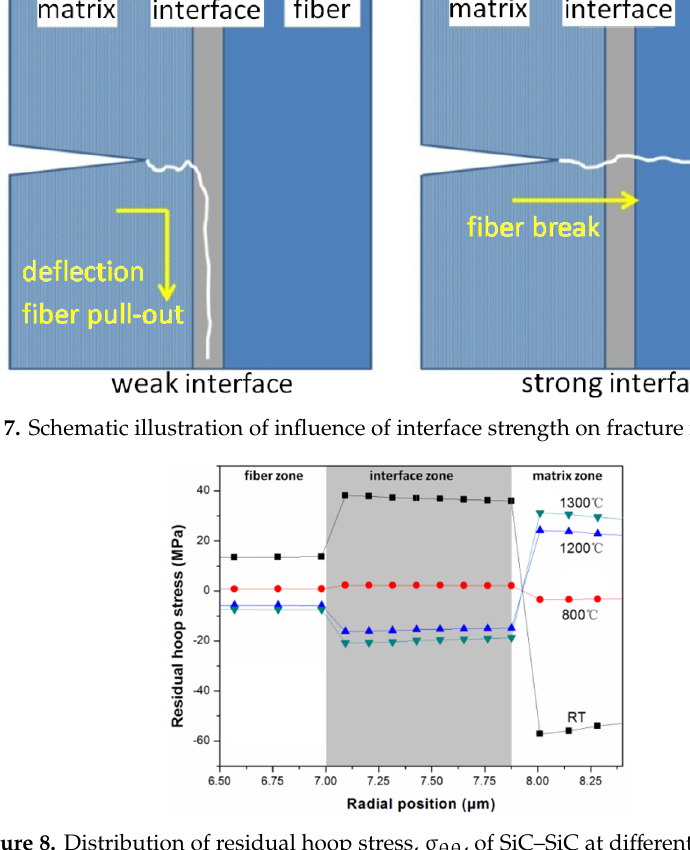
Figure 8. Distribution of residual hoop stress, σ θθ , of SiC–SiC at different temperature.